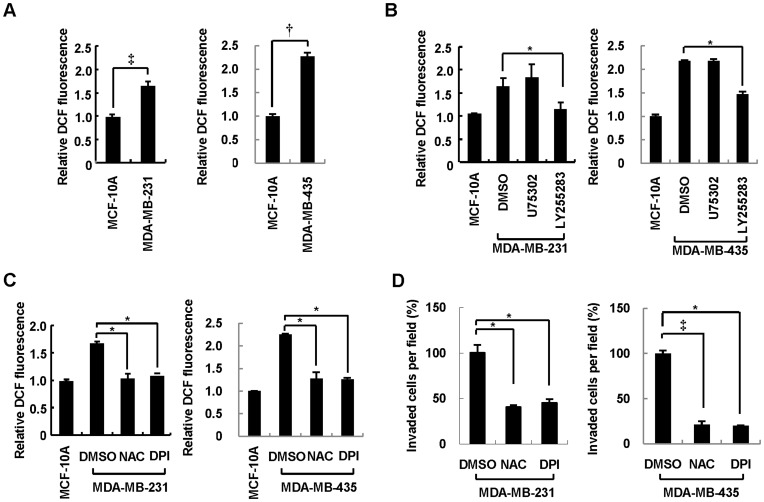
ROS production occurs downstream of BLT2 and contributes to the invasiveness of breast cancer cells.(A) MCF-10A, MDA-MB-231, and MDA-MB-435 cells were incubated in the presence of 0.5% serum for 3 h and then loaded with the diacetate form of DCF (20 µM) for 20 min. Intracellular ROS levels were then determined by flow cytometric analysis of DCF fluorescence. (B) MDA-MB-231 and MDA-MB-435 cells were incubated with U75302 (1 µM), LY255283 (10 µM), or DMSO vehicle for 1 h before determination of the intracellular level of ROS as in (A). (C and D) MDA-MB-231 and MDA-MB-435 cells were incubated with NAC (5 mM), DPI (0.5 µM), or DMSO vehicle for 1 h and then monitored for ROS levels (C) or assayed for invasiveness in the continued presence of the test agents (D). All data are expressed relative to the corresponding control value and are means±SD from five independent experiments. *P<0.05, †P<0.01, ‡P<0.005.